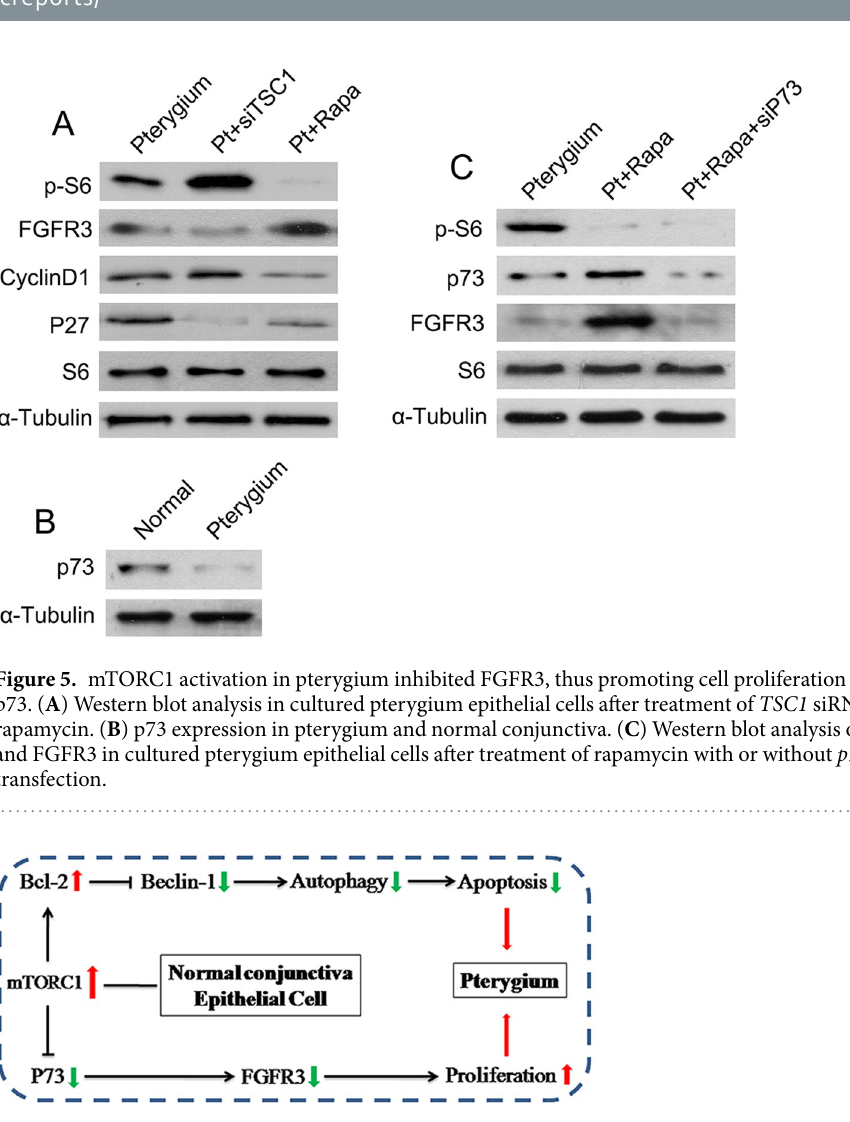
Figure 6. A schematic model depicting the role of mTORC1 in the regulation of pterygium apoptosis and cell proliferation via targeting autophagy and